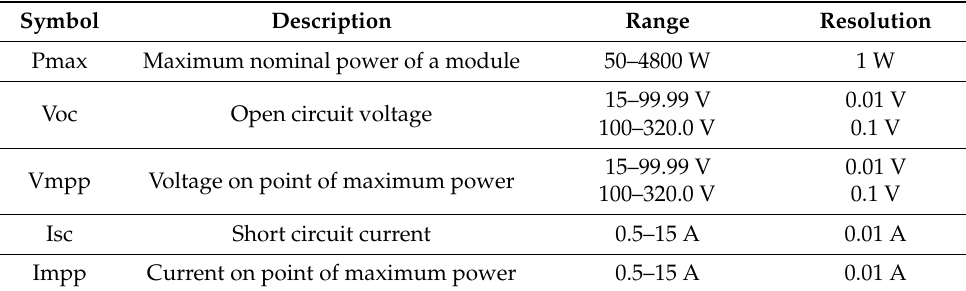
Table 2. Parameters measurement capabilities of “Solar IV-e” photovoltaic (PV)